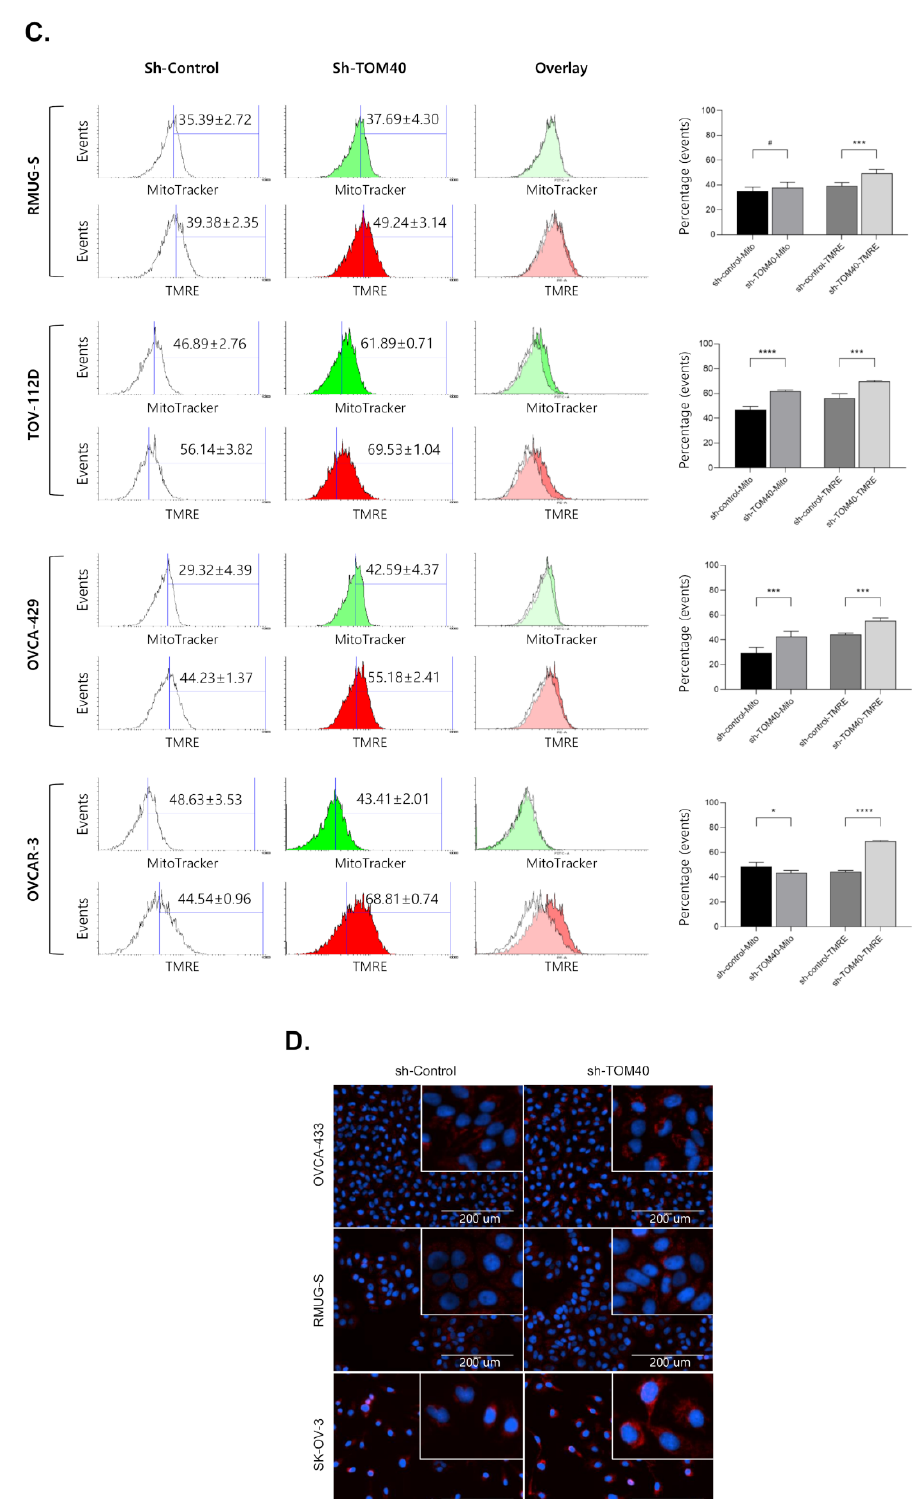
Figure 4. The knockdown of TOM40 expression increases the mitochondrial membrane potential. Epithelial ovarian cancer (EOC) cells that stably express sh-control and sh-TOM40 were seeded at 2.5 × 10 6 cells per wells and stained with 2 μM tetraehylbenzimidazolylcarbocyanine iodide (JC-1) for 15 min. The JC-1 staining was measured by fluorescence-activated cell sorting (FACS) analysis and fluorescence microscopy imaging. ( A ) Representative images of FACS analysis of 5,5’,6,6’-tetrachloro- 1,1’,3,3’-tetraethylbenzimidazolylcarbocyanine iodide (JC-1) staining: Quantification of the percentage of cells is shown in the top-left and top-right regions of dot plots to count JC-1 aggregation